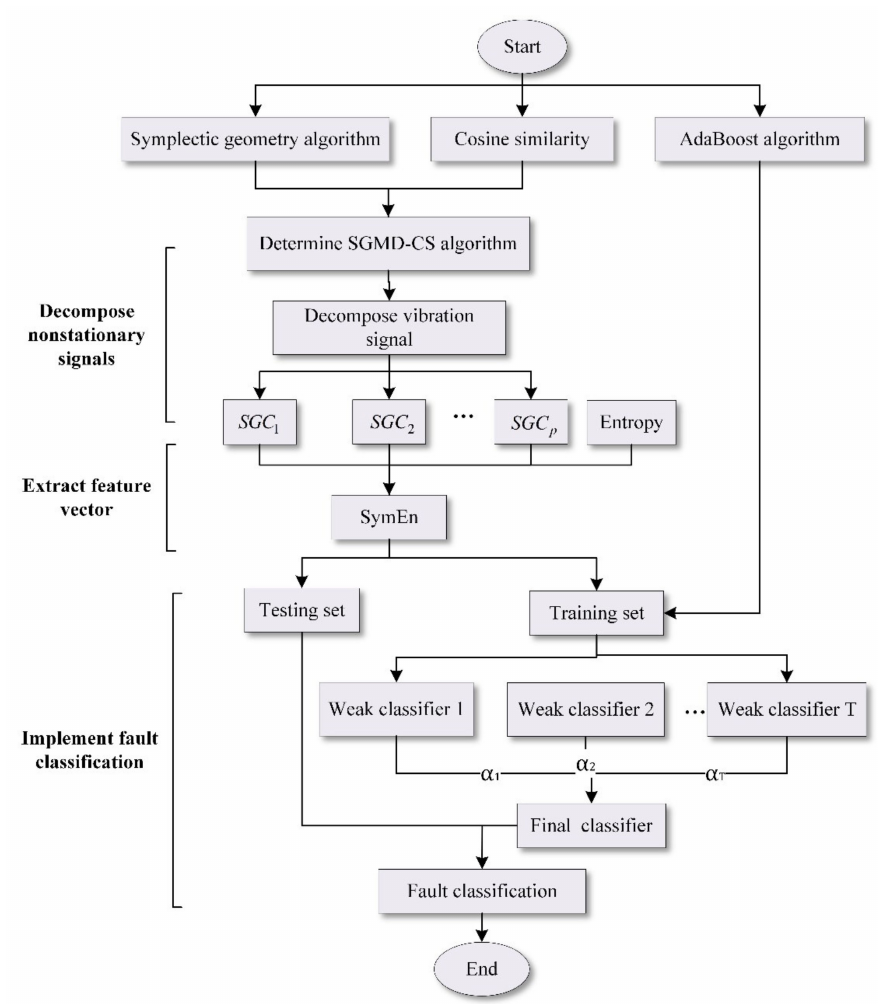
Figure 9. Flowchart of fault